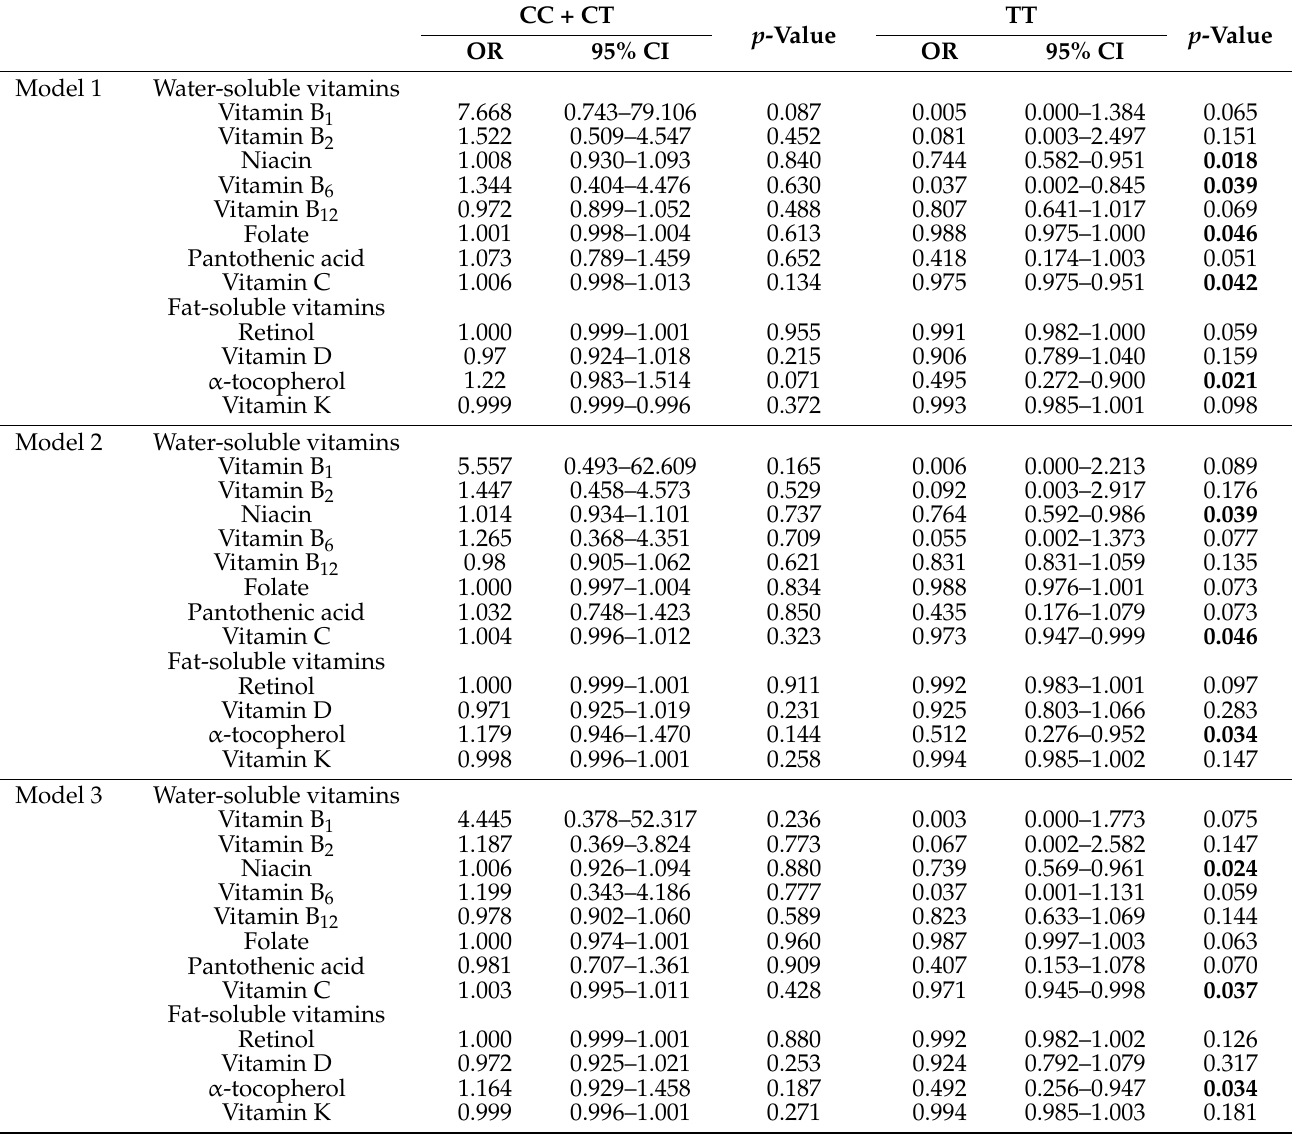
Table 4. Association between antioxidant vitamins intake and CKD according to rs883484